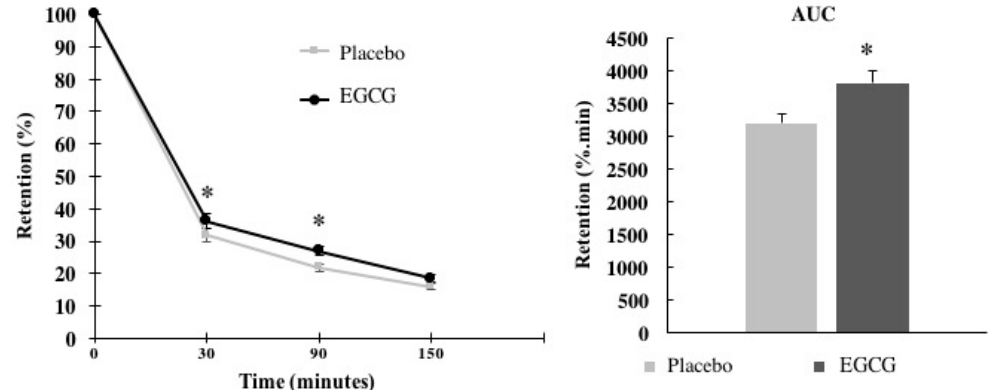
Figure 3. Relative gastric retention (%). Relative gastric retention variations and the area under the curve between treatments (EGCG × placebo) were assessed using the two-way ANOVA (adjusted to individual variation). Values are mean ± SEM. Differences found are highlighted with * ( p < 0.05).